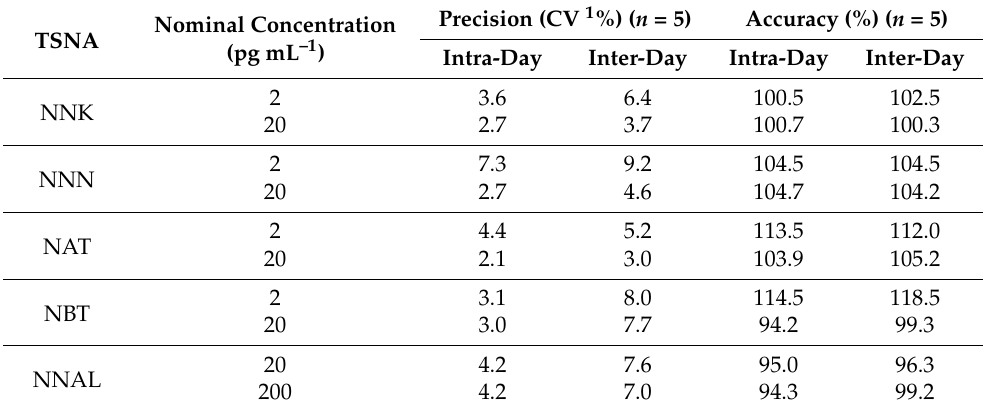
Table 2. Precision and accuracy of the in-tube SPME LC–MS/MS method for